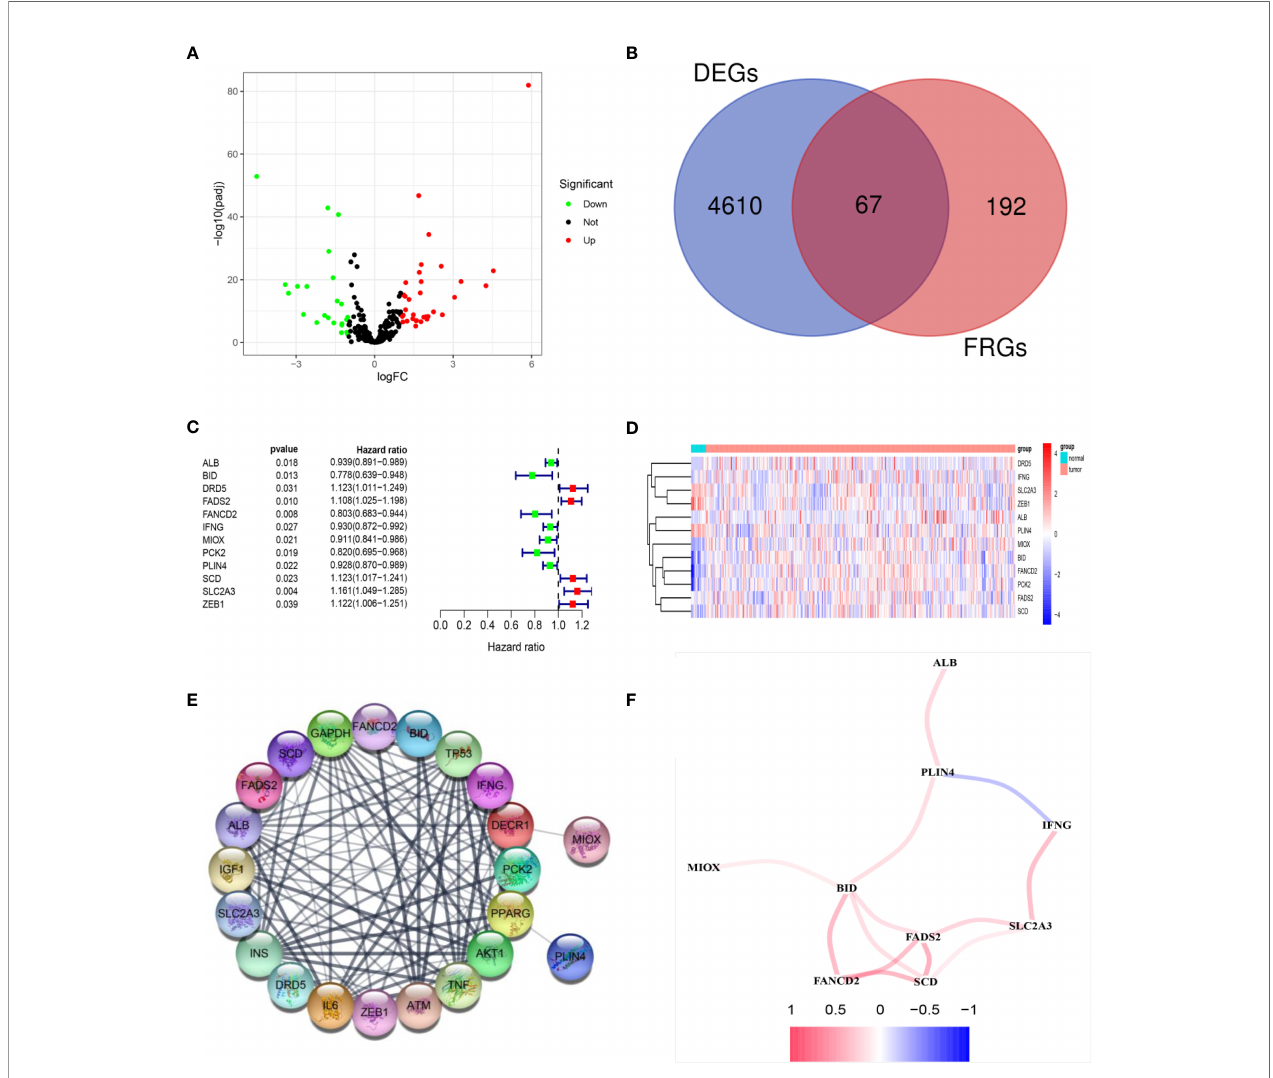
FIGURE 2 | Identi fi cation of prognostic DEGs related to FRGs in the TCGA cohort. (A) The 67 overlapping genes were shown in the volcano map. Forty genes were upregulated and 27 genes were downregulated in tumor tissues. (B) Venn diagram to identify DEGs related to FRGs. (C) Univariate Cox proportional regression analysis showed that the 12 genes were signi fi cantly associated with OS. (D) A heatmap showing the expressions of the 12 prognostic genes in the tumors and normal tissues. (E) PPI network provided interactive information among the candidate prognostic genes. (F) The correlation network of candidate genes. Different colors represented the correlation coef fi